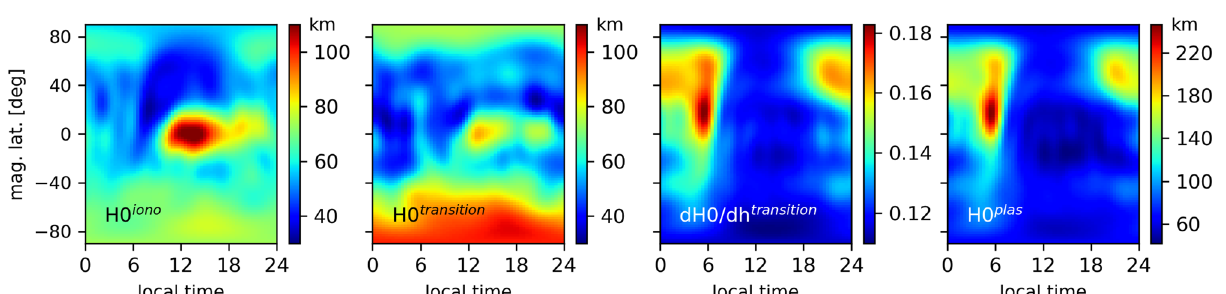
Figure 4. Scale height estimations for the ionosphere ( H 0 iono ), transition region ( H 0 transition and ∂ H 0 /∂ h transition ) and plasmasphere ( H 0 plas ) in terms of local time by magnetic latitude. The representations were obtained using RO and Van Allen Probes data of the first 60 days of 2014, i.e., during the Southern